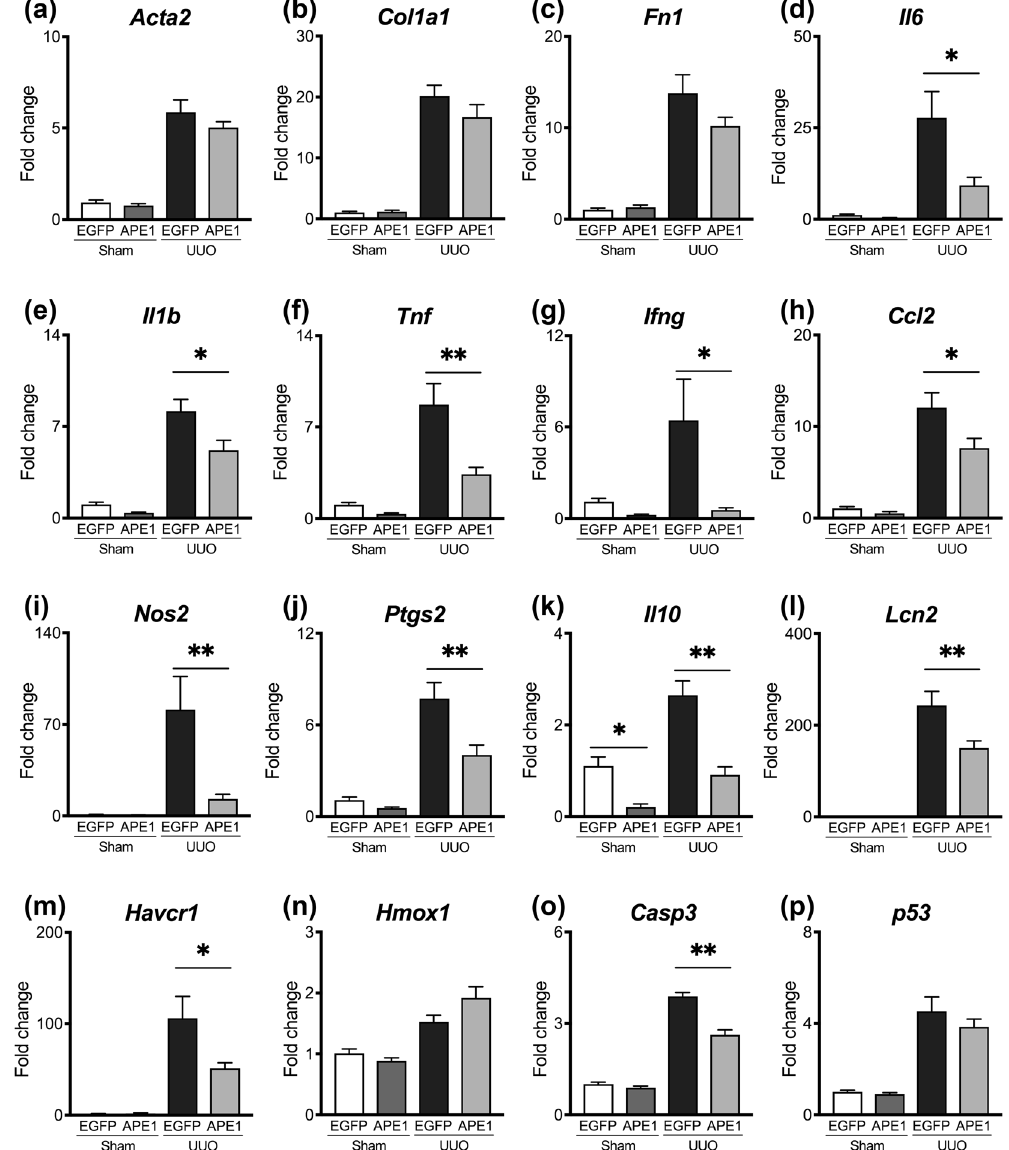
Figure 3. pCAG-APE1 injection reduces the expression of mRNA associated with inflammation and apoptosis. qPCR measuring markers of fibrosis ( Acta2 ( a ) , Col1a1 ( b ) , Fn1 ( c )), inflammation ( Il6 ( d ), Il1b ( e ), Tnf ( f ), Ifng (g), Ccl2 ( h ), Nos2 ( i ), Ptgs2 ( j ) , Il10 ( k )), tubular injury ( Lcn2 [Ngal] ( l ) , Havcr1 [Kim1] ( m )), anti-oxidation (Hmox1 ( n )), and apoptosis ( Casp3 ( o ) , p53 ( p )), comparing mice subjected to unilateral obstructed ureter (UUO) procedures and sham-operated mice, injected with pCAG-APE1 or pCAG-EGFP (control) vectors. Data are presented as the mean ±